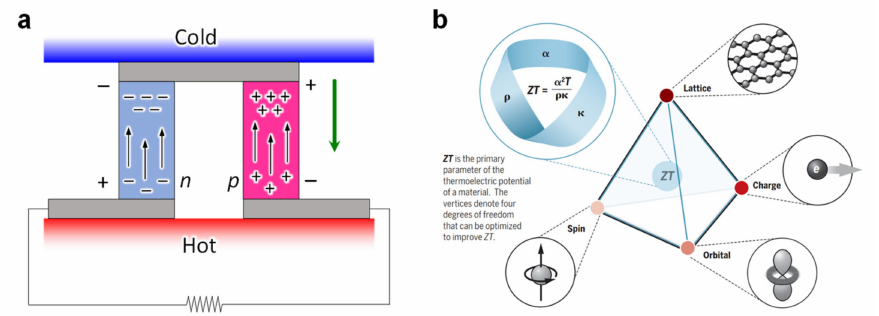
Figure 12. ( a ) A schematic of a thermoelectric sensor. ( b ) Thermoelectric materials research is a multidisciplinary study involving charges, spins, orbitals, and lattice degrees of freedom in matter. Studies into electrical resistivity ( ρ ), the Seebeck coefficient ( α ), and thermal conductivity ( κ ) should be conducted simultaneously. Reproduced with permission from [50], Copyright 2017, American Association of the Advancement of